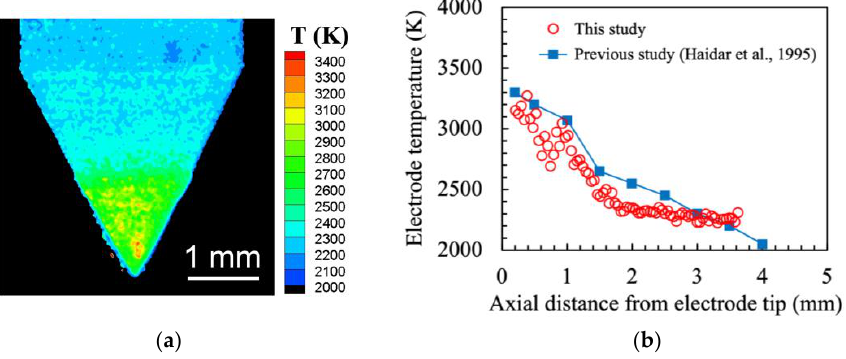
Figure 5. Electrode surface temperature in DCEN polarity: ( a ) two-dimensional temperature distribution; ( b ) temperature distribution along the central axis.